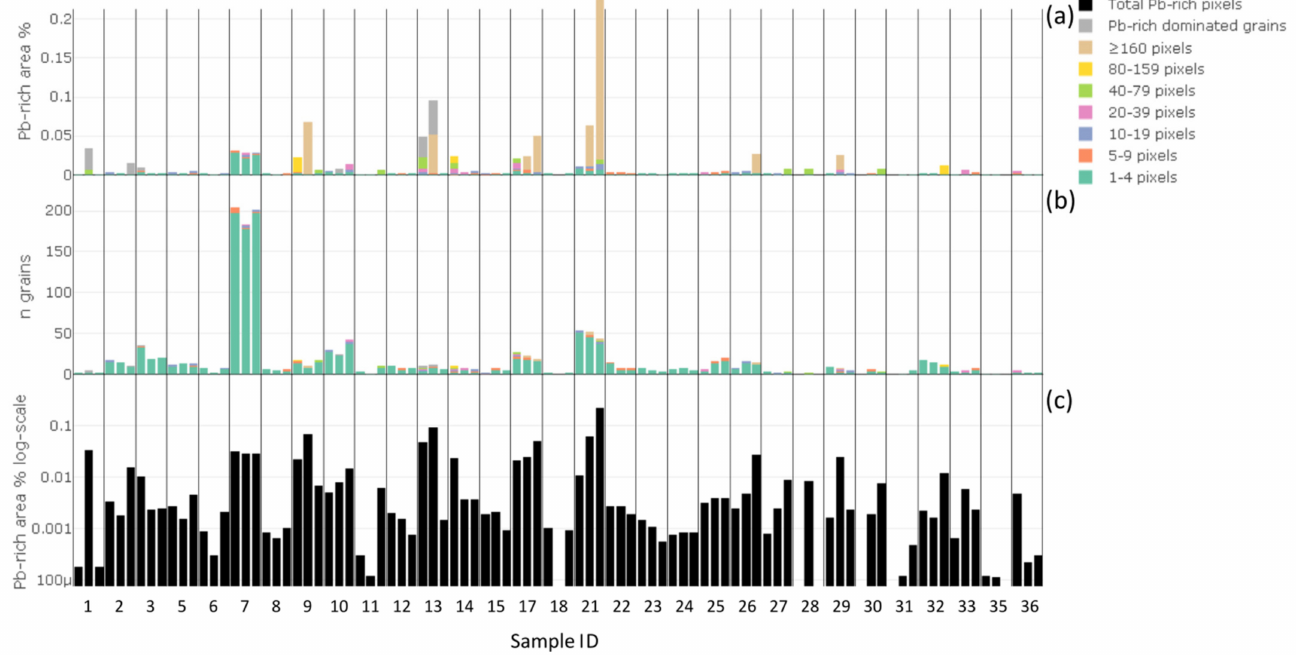
Figure 10. Abundance of Pb-rich PARC group and number of host grains for all analysed regions (three regions per sample). ( a ) Detected Pb-rich abundance, reported as (silhouette) area %, split by category for number of Pb-rich pixels per host grain; ( b ) number of host grains split by category as in ( a ); ( c ) total Pb-rich abundance with logarithmic y-axis scale (blank columns represent no detected Pb-rich